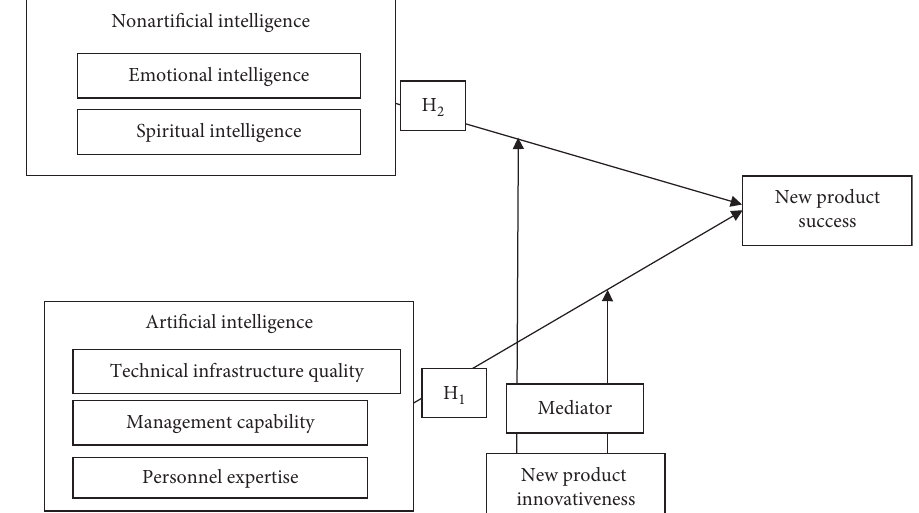
Figure 4: Theoretical